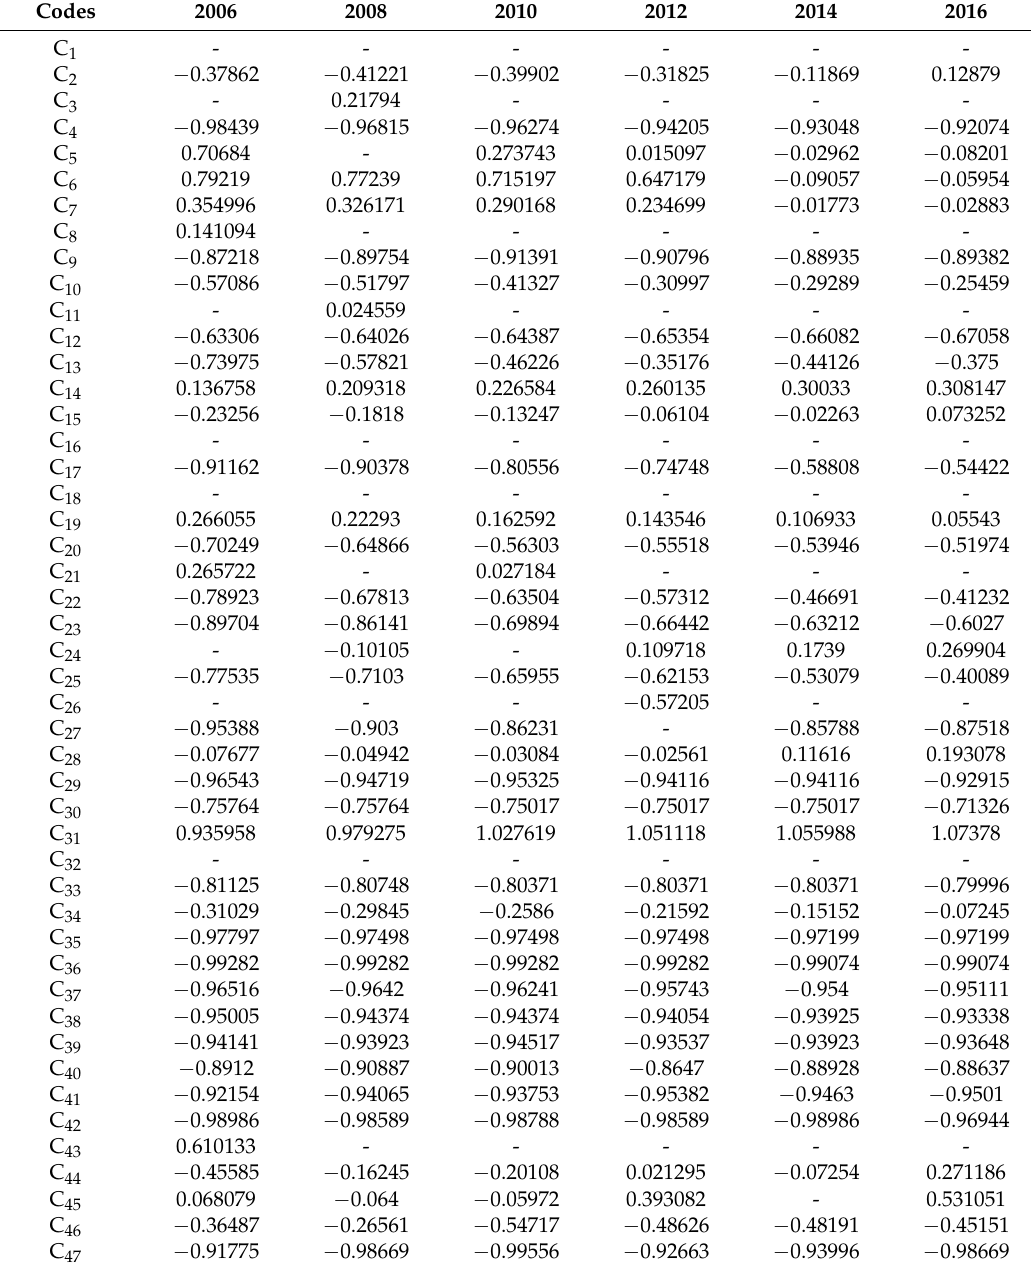
Table A1. Standardized data of